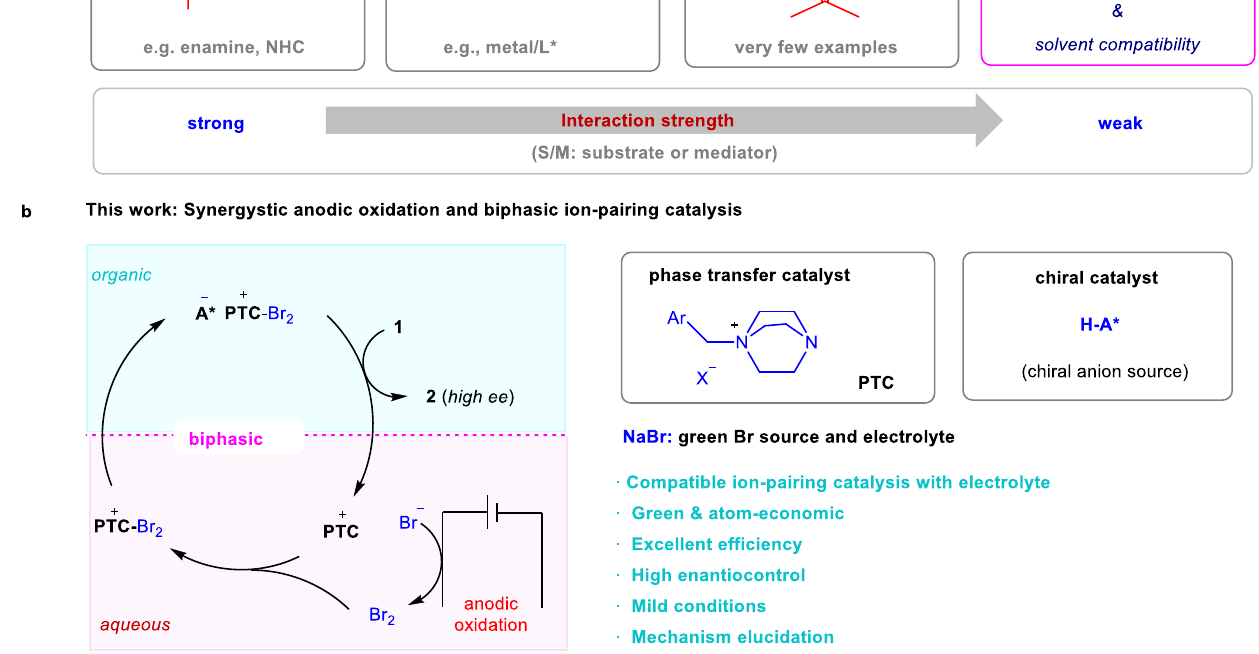
Fig. 1 | Introduction to asymmetric electricity-driven catalysis and our design strategy by phase-transfer ion-pairing catalysis. a Introduction to different strategiesinasymmetricelectrochemicalcatalysis.Covalentbondanddativebond withthechiralcatalyst have been established,but weakbond interactionhasbeen